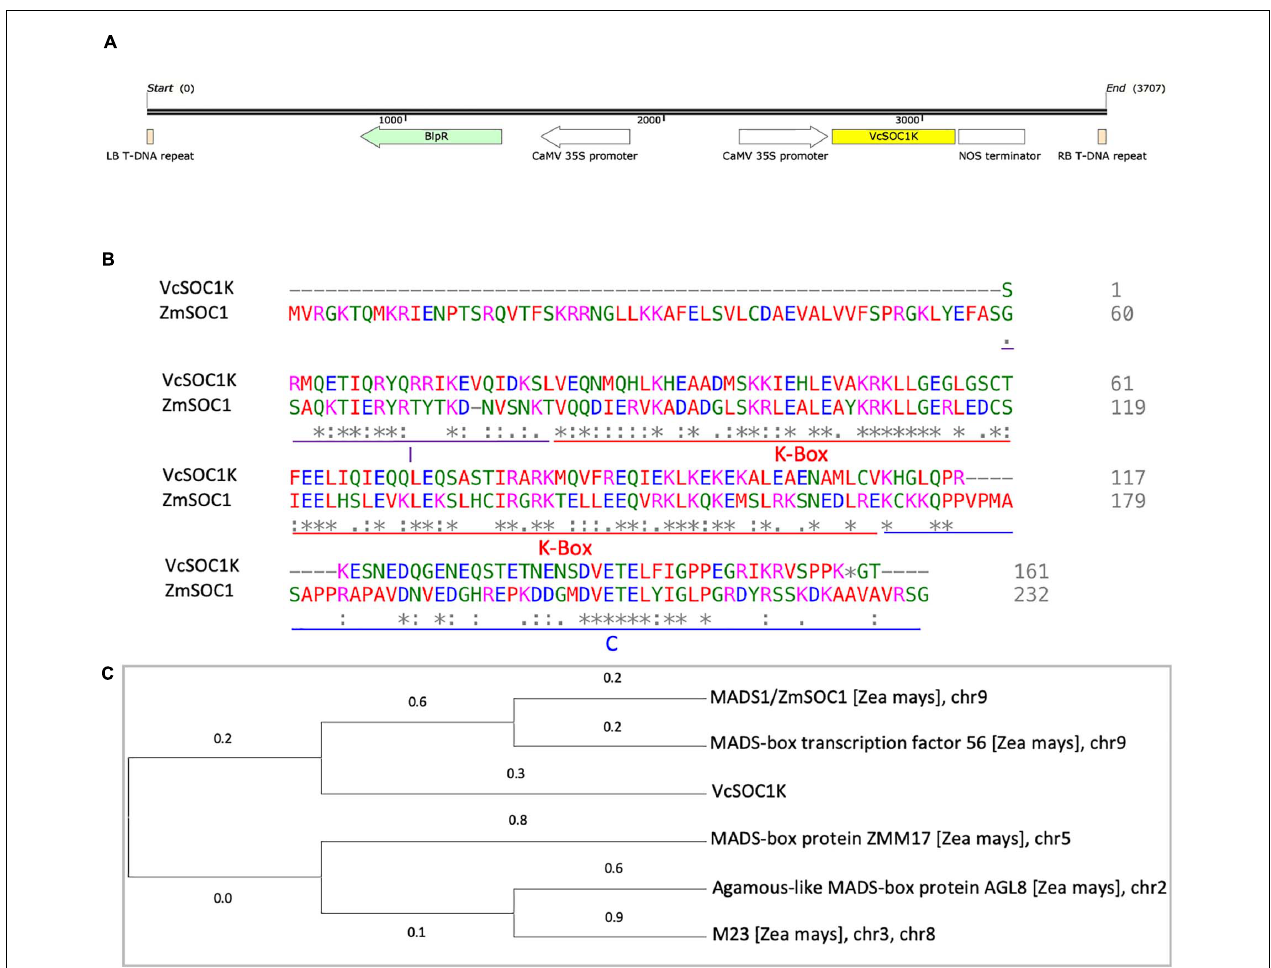
FIGURE 1 | Comparison of VcSOC1K and the selected maize MADS-box genes. (A) Diagram of the T-DNA region of the pTF101.1-ZmSOC1 vector. LB: left border. RB: right border. (B) Protein sequence alignment of the VcSOC1K and ZmSOC1 (GenBank #: HQ858775.1). (C) Phylogenetic analysis of maize MADS-box proteins that showed similarities to the VcSOC1K using the Maximum Likelihood method conducted in MEGA X. There were a total of 172 positions in the final dataset. The tree with the highest log likelihood (–1672.77) is shown. Chromosome numbers refer to the positions in the sequence database Zm-B73-REFERENCE-NAM-5.0 (the maize representative genome, B73, version 5) at Maize Genetics and Genomics Database (MaizeGDB).